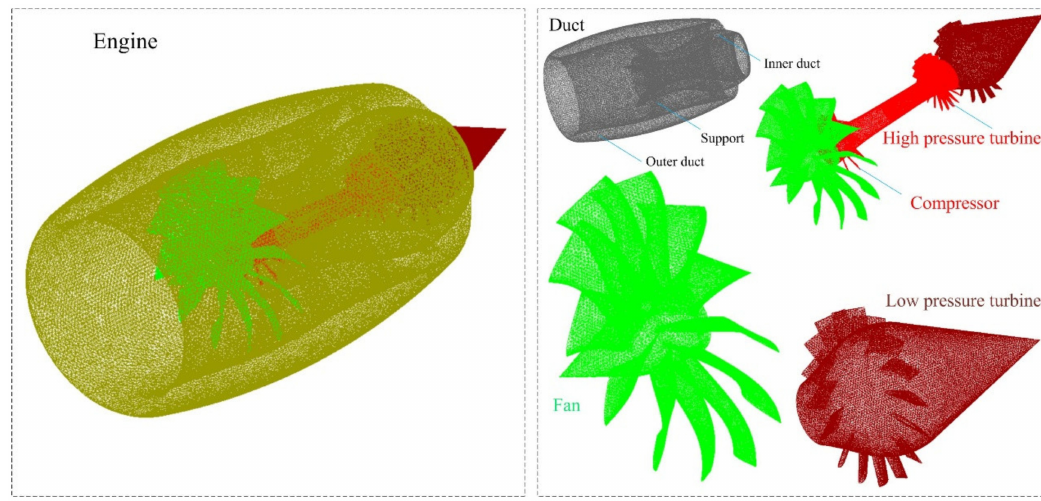
Figure 5. Surface mesh distribution of various components of the turbofan engine.